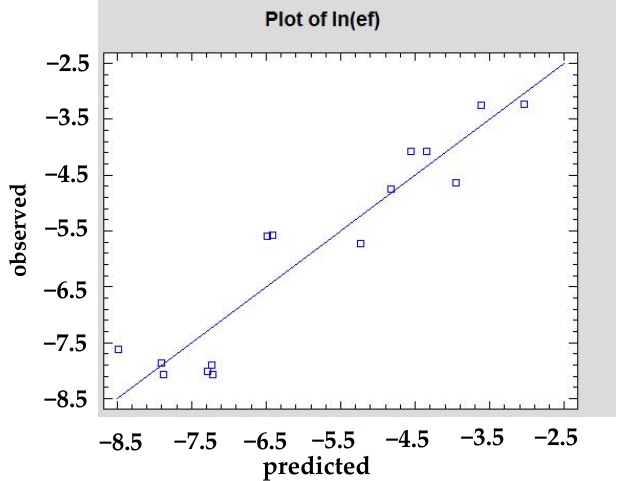
Figure 3. Observed versus predicted values graph of ln(ef). Table 2. Test of normality of residuals.